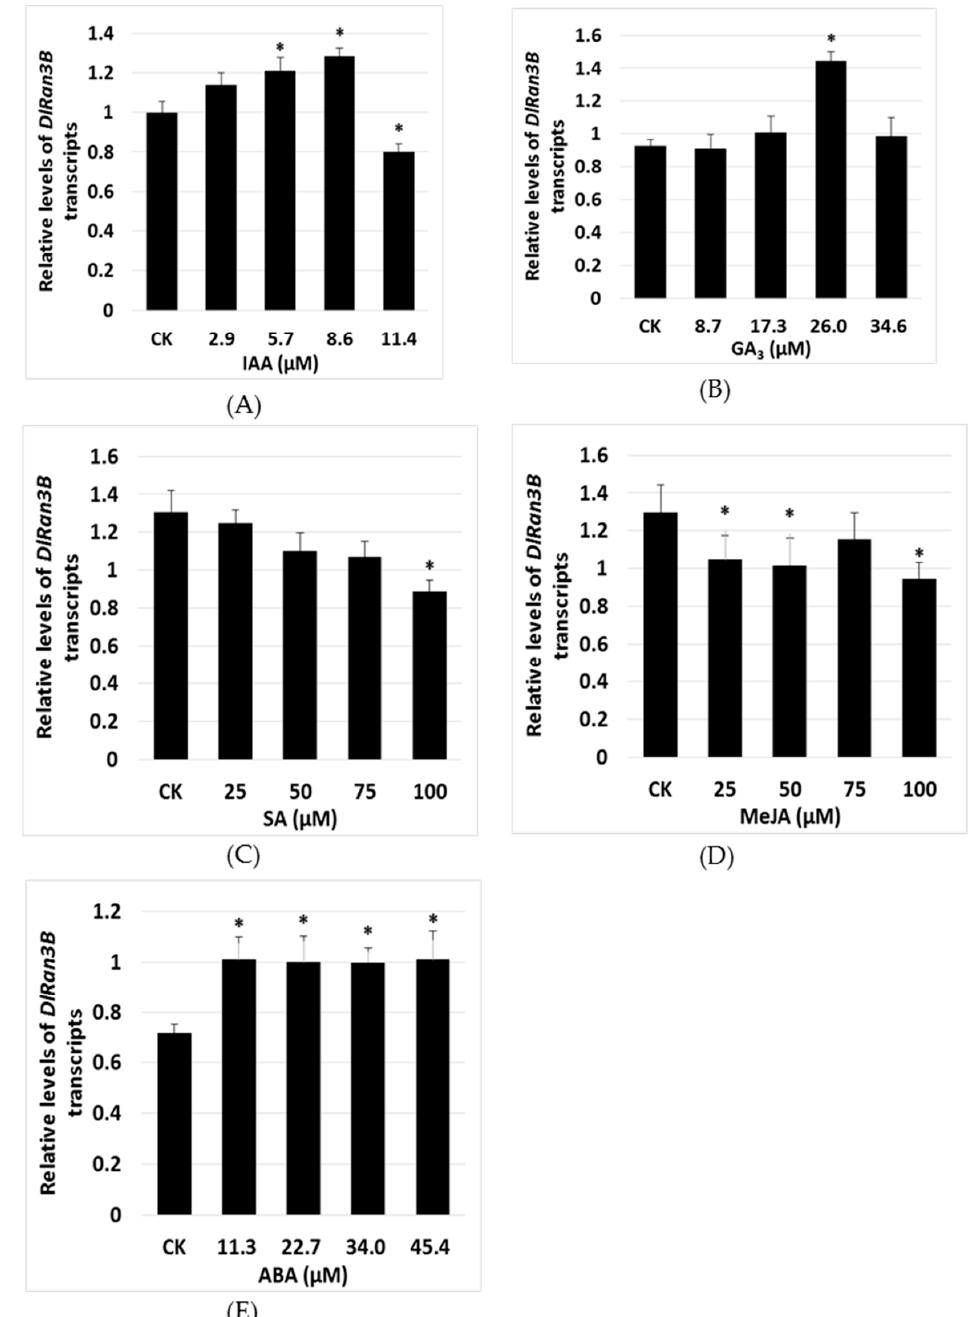
Figure 3. DlRan3B expression in response to exogenous plant hormones. ( A – E ) ECs were treated with listed hormones at indicated concentrations as follows, ( A ) indoleacetic acid (IAA) (2.9, 5.7, 8.6, and 11.4 μ M); ( B ) gibberellin A3 (GA3) (8.7, 17.3, 26.0, and 34.6 μ M); ( C ) salicylic acid (SA) (25, 50, 75, and 100 μ M); ( D ) methyl jasmonte (MeJA) (25, 50, 75, and 100 μ M); or ( E ) abscisic acid (ABA) (11.3, 22.7, 34.0, and 45.4 μ M). The DlRan3B expression level was normalized to those of EF-1a , eIF-4a , and DLFSD1a . Data are shown as means ± SD ( n = 3); the level of significant differences in contrast to the control (CK) are indicated with an asterisk (*) and were assessed by a one-way ANOVA test (* p < 0.05).